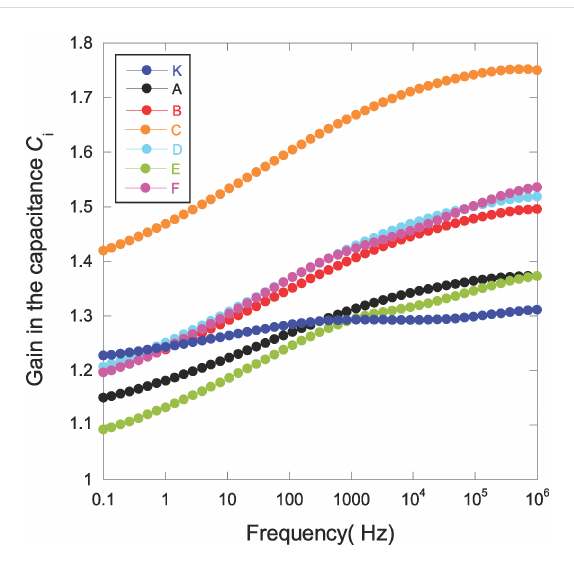
Figure 10: Gain in the gate insulation capacitance by replacing conventionally processed parylene C (sample O) with plasma- combined CVD process incorporating silver-oxide nanoparticles. Accu- racy in the gain due to geometric dimensions of samples is in the range ±0.1 (sample F) to ±0.18 (sample